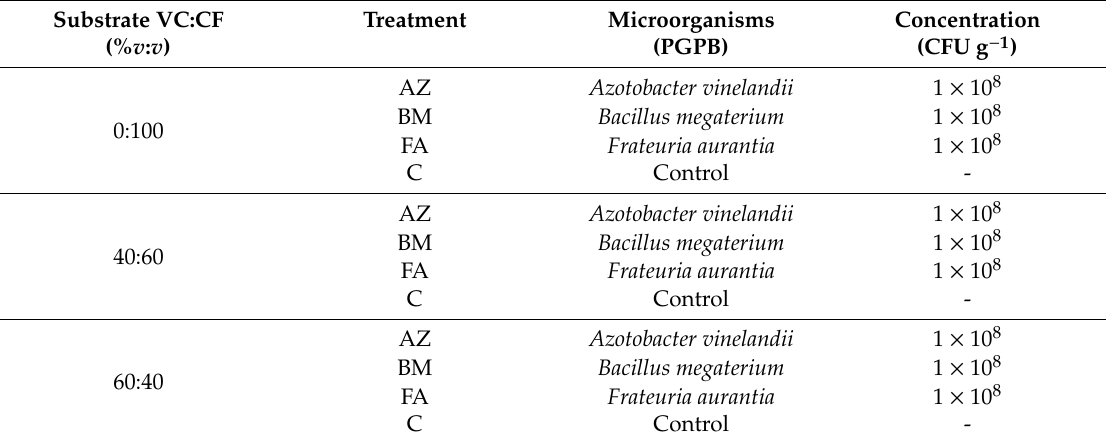
Table 1. Treatment description according to substrate mixture and microorganisms (PGPB)